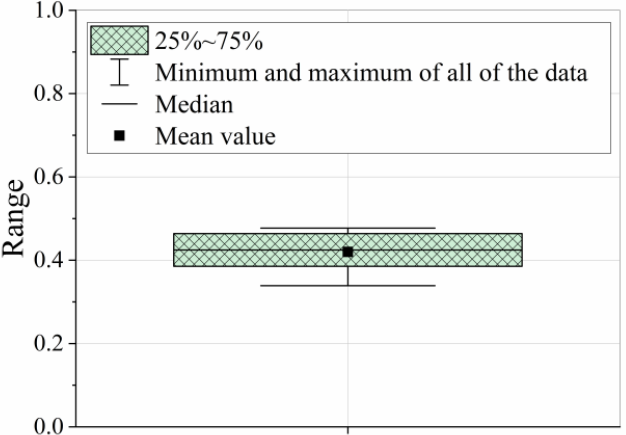
Figure 5. Graphical description of the variation between samples using the boxplot method.